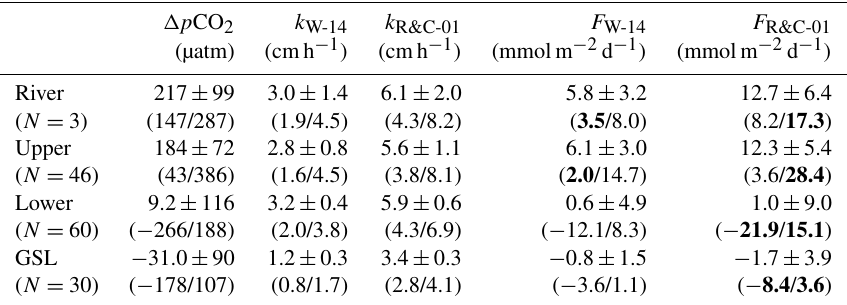
Table 2. Mean, standard deviation, and range of (cid:49)p CO 2 , k W-14 , k R&C-01 , F W-14 , and F R&C-01 in the surface waters of the St. Lawrence River, USLE, LSLE, and GSL during all sampling months. k W-14 is the gas transfer velocity given by the Wanninkhof (2014) relationship, whereas k R&C-01 is that given by Raymond and Cole (2001). Values of F W-14 are taken to be the theoretical lower limit of air–sea gas exchange, whereas values of F R&C-01 are the upper limit. Numbers in parentheses indicate the ranges observed; the extreme F data points are shown in bold.